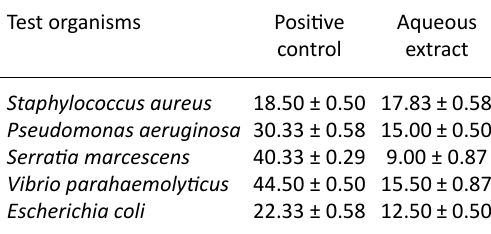
table 1. Organisms with corresponding positive controls Test